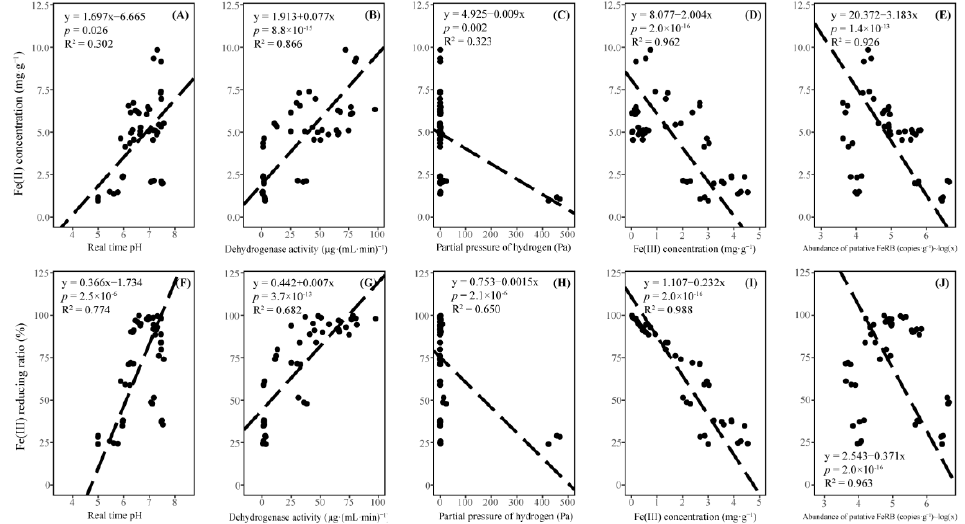
Figure 4. Correlation between real time pH, dehydrogenase activity, partial pressure of hydrogen, Fe(III) concentration and abundance of putative Fe(III) reducing bacteria (FeRB) and Fe(II) concentration (A–E), as well as Fe(III) reducing ratio (F–J).